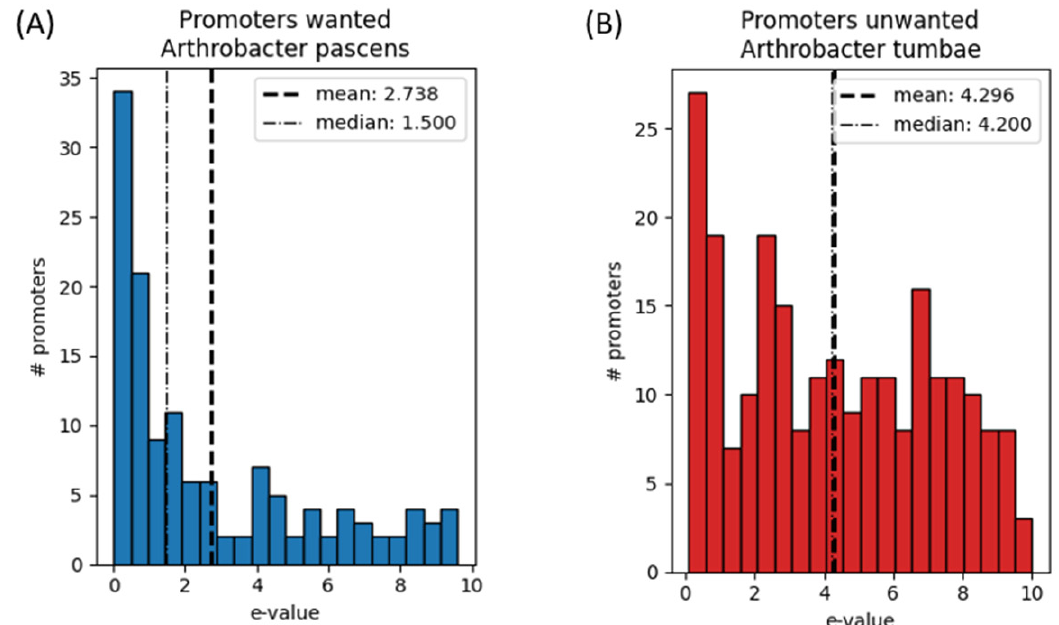
Figure 12. E-value scores histogram sample from a MAST run for a final motif set constructed for a pair species from the Arthobacter family, including the wanted host Arthrobacter pascens ( A ) and unwanted host Arthrobacter tumbea ( B ). In both A and B, mean and median E-values are indicated. Wanted host motifs were calculated by a STREME run using promoter sequences as primary set and intergenic regions as control set. Unwanted host anti ‐ motifs were calculated by a STREME run using intergenic regions as primary set and promoter sequences as control set. Mean and median E ‐ values of the wanted host are lower than mean and median E ‐ values for the unwanted host, with a p ‐ value of 7.184 × 10 − 8 .